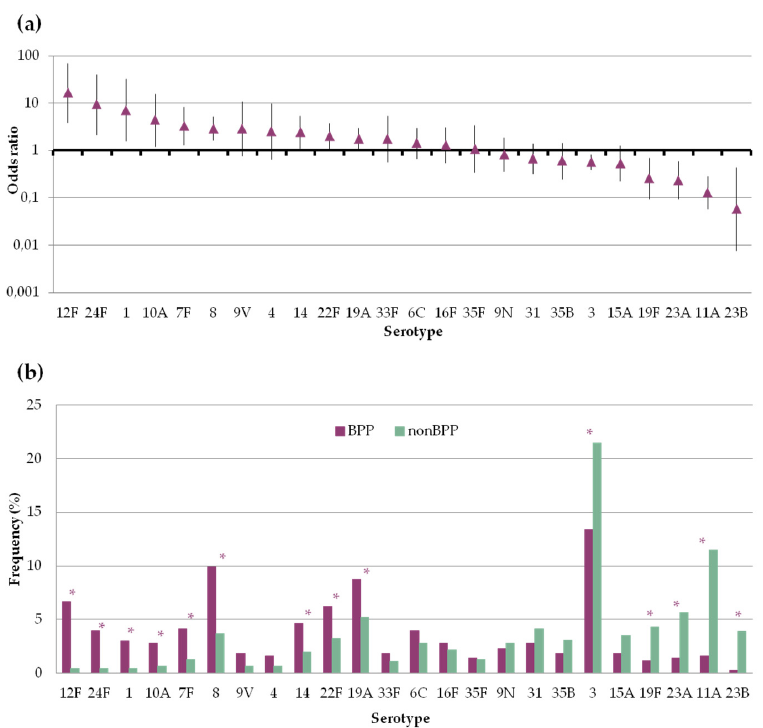
Figure 3. Frequency of pneumococcal serotypes in bacteremic (BPP) and non-bacteremic pneumonia (non-BPP). Only serotypes accounting for ≥ 10 episodes are shown ( a ) Serotype specific odds ratio and 95% CI comparing BPP and non-BPP. ( b ) Serotype distribution of pneumococci causing BPP or non-BPP. Asterisks indicate statistically significant changes ( p <